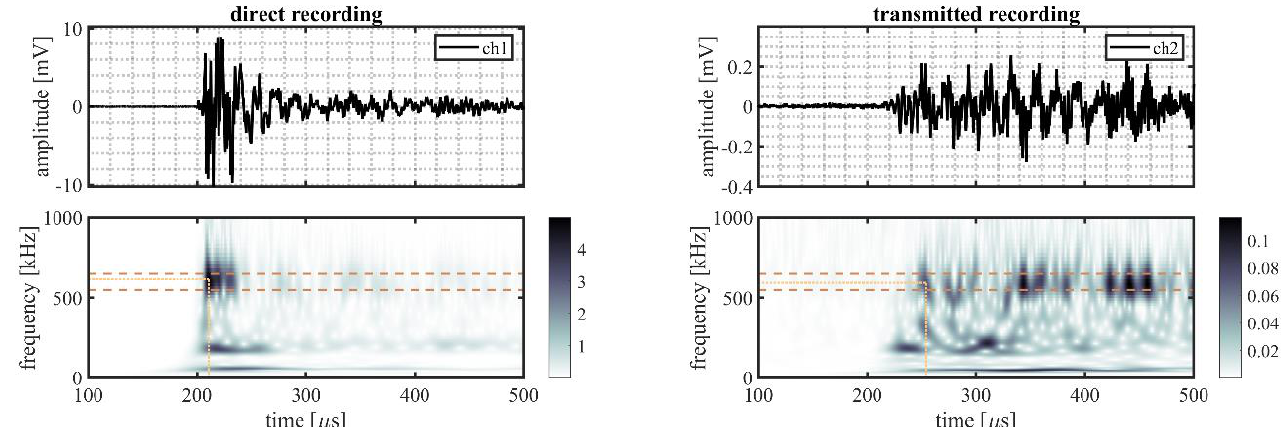
Figure 6. Randomly selected event recorded by VS600-Z2 sensors, originating from a source location S22, showing: the time traces recorded on the outer raceway (ch1, top left ) and on the inner raceway (ch2, top right ), and the time – frequency representation of the recorded signals on the outer ( bottom left ) and the inner ( bottom right ) raceways. The detected magnitude in the time–frequency represen- tations of the signals are indicated by the intersection of the dotted lines; the dashed lines indicate the frequency range of interest (550–650 kHz).